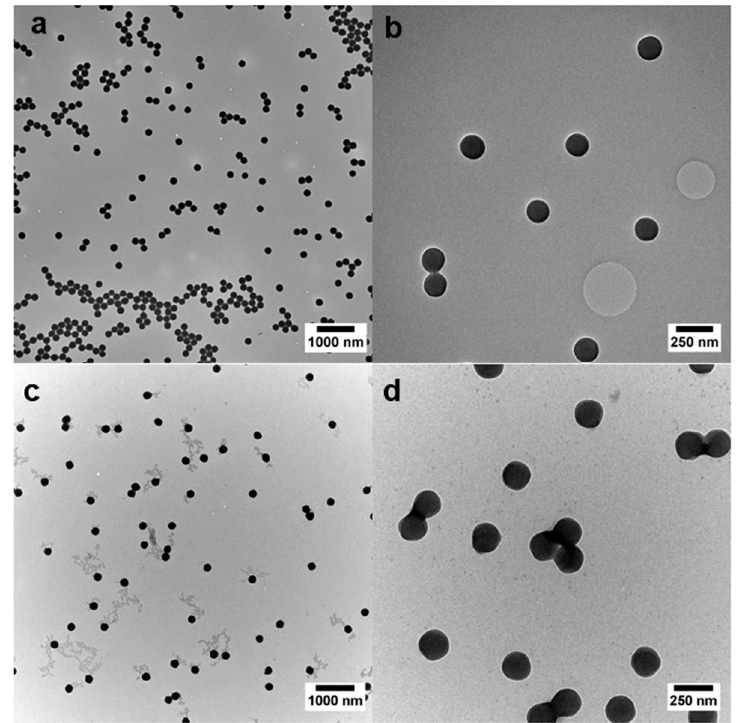
Figure 2. TEM Images of the P(MMA- co -ALMA) core particles ( a , b ) and the corresponding P(MMA- co -ALMA)@P(EA- co -MPSEt) core–shell particles ( c , d ). Scale bars correspond to 1000 nm ( left ) and 250 nm ( right ), respectively.